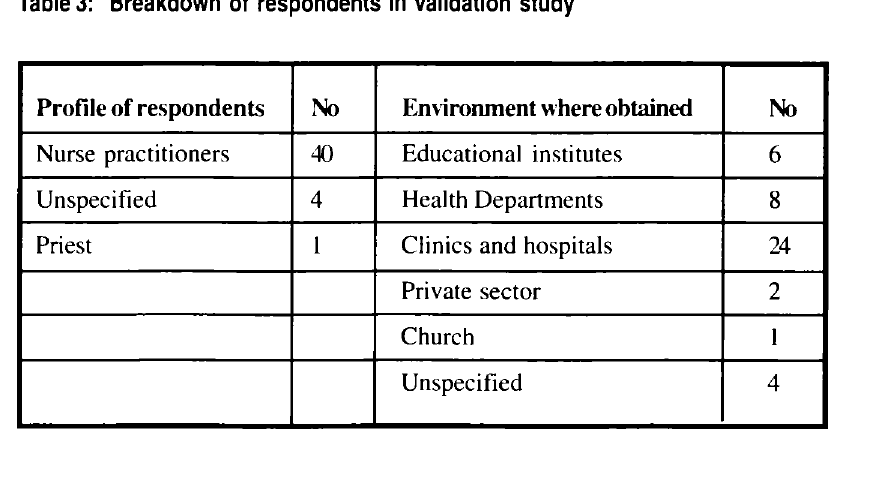
Table 3: Breakdown of respondents in validation study